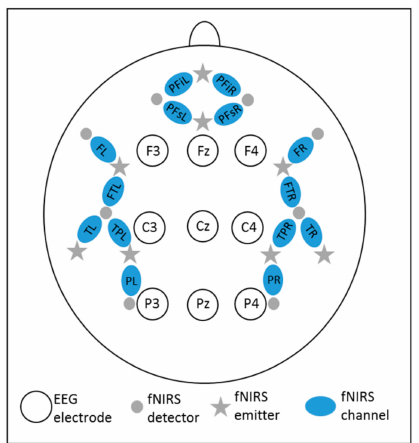
Figure 1. EEG-fNIRS positioning. PFi = prefrontal inferior, PFs = prefrontal superior, F = frontal, FT = fronto-temporal, T = temporal, TP = temporo-parietal, P = parietal, L = left, R =